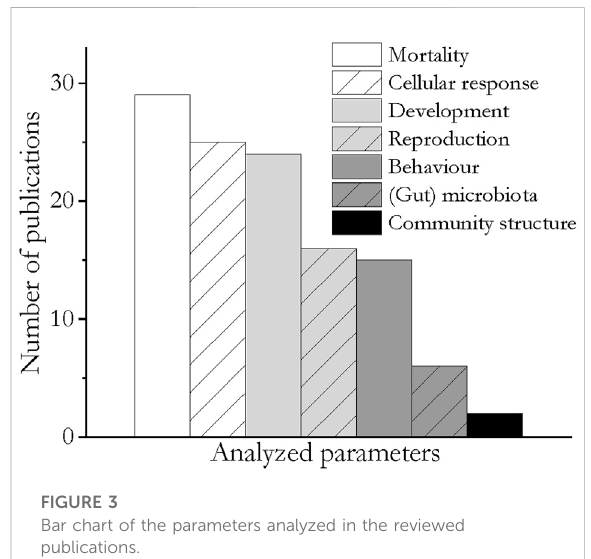
FIGURE 3 Bar chart of the parameters analyzed in the reviewed